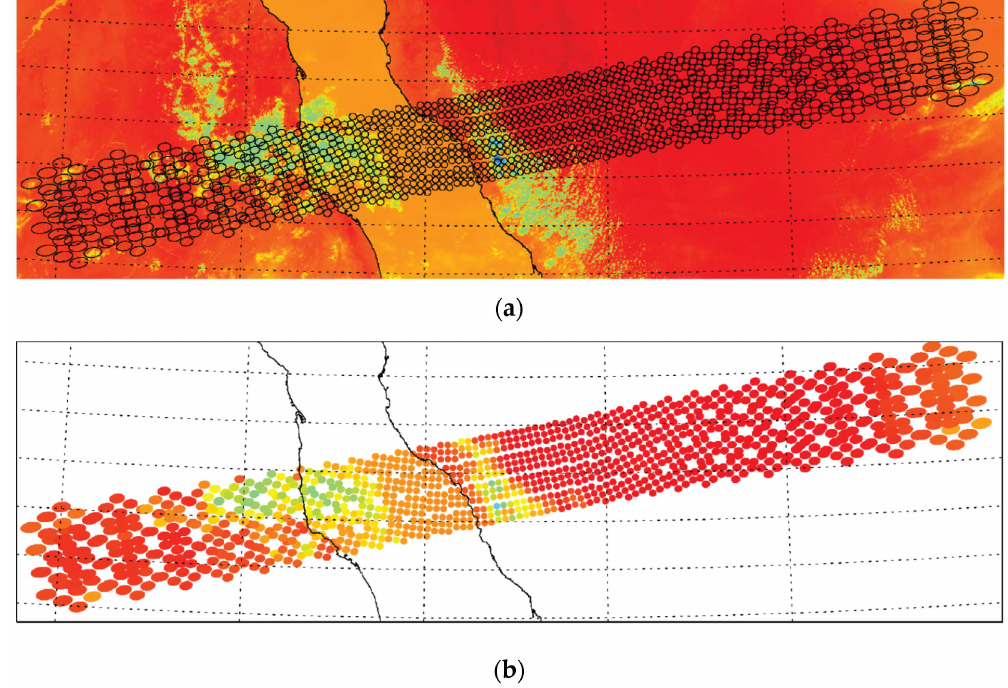
Figure 3. Enlarged plots four CrIS scans in Figure 2, including ( a ) projected CrIS FOV footprints overlapped with VIIRS image and ( b ) CrIS FOV